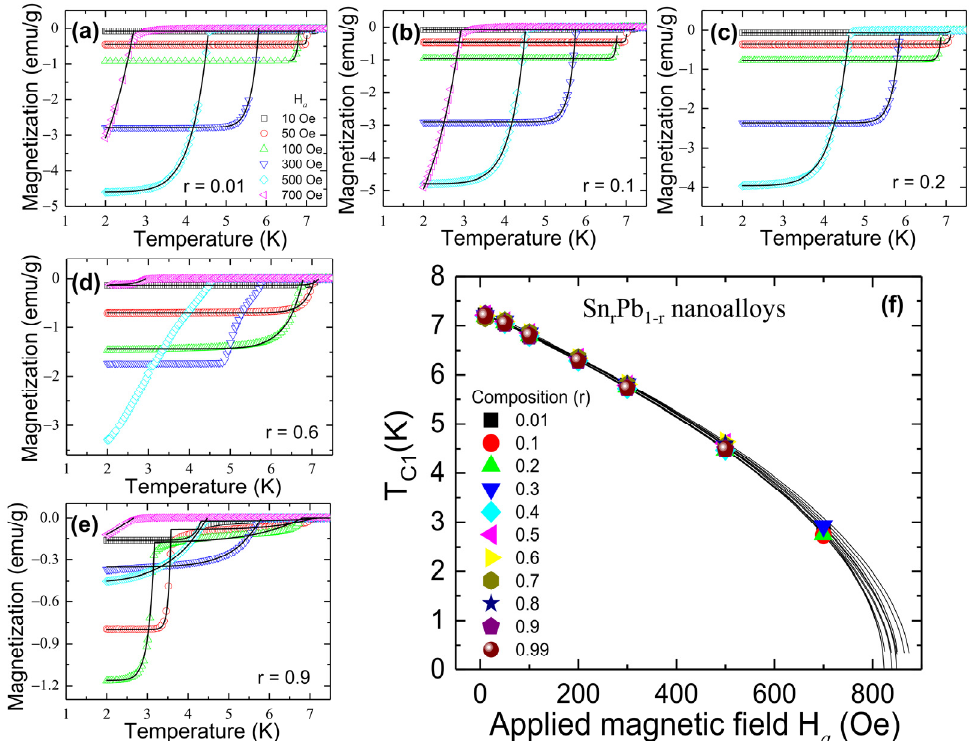
Figure 6. ( a – e ) the effect of applied field H a on the transition temperature T C1 of Sn r Pb 1-r nanoalloys; ( f ) the H a dependency of T C1 . The solid line is fitted to the expression given in the text.